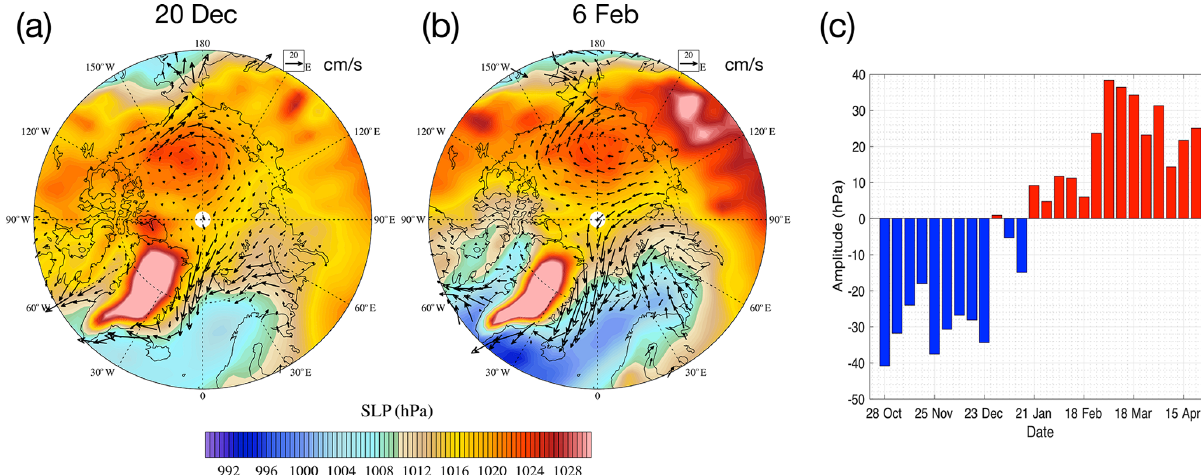
Figure 6. Daily sea level pressure from the NYF dataset (filled contour) and modeled sea ice motion by TS045 (vectors) on 20 December (a) and 6 February (b) . The wintertime Arctic oscillation (AO) index of the NYF dataset is in panel (c) . See the text for detailed methods to compute the